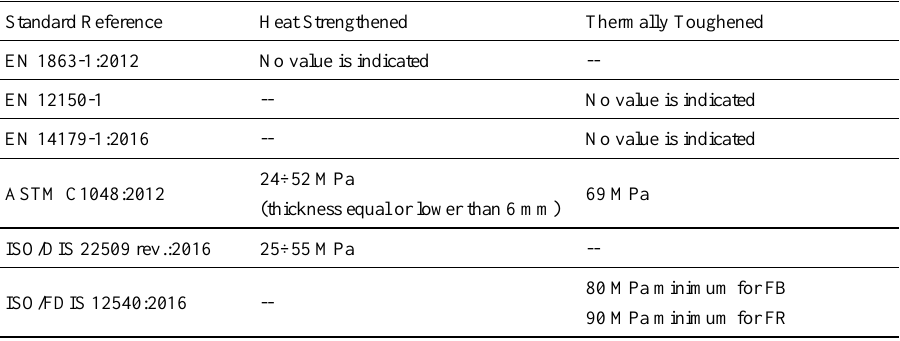
Table 1: Reference Value of Surface Compressive Stress